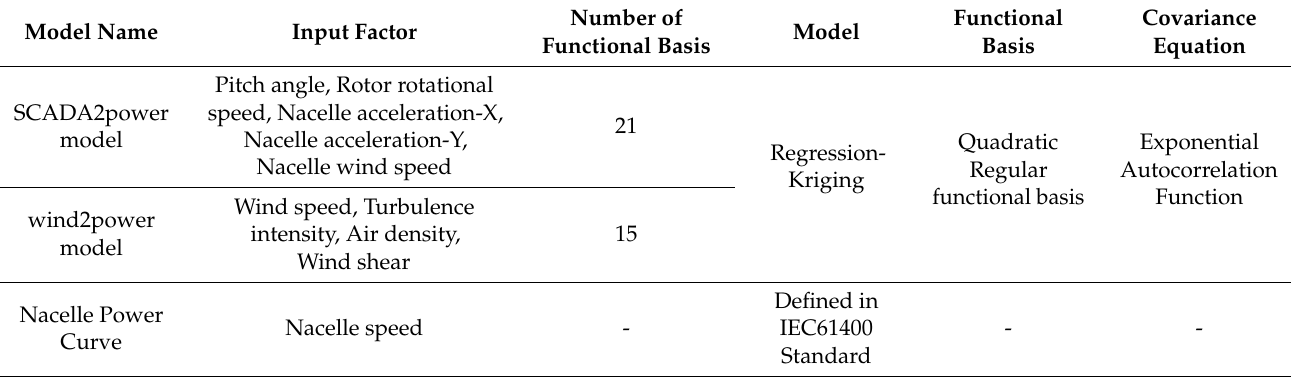
Figure 12. Power curve based on training database. Table 1. Specific parameters of the established output power model.